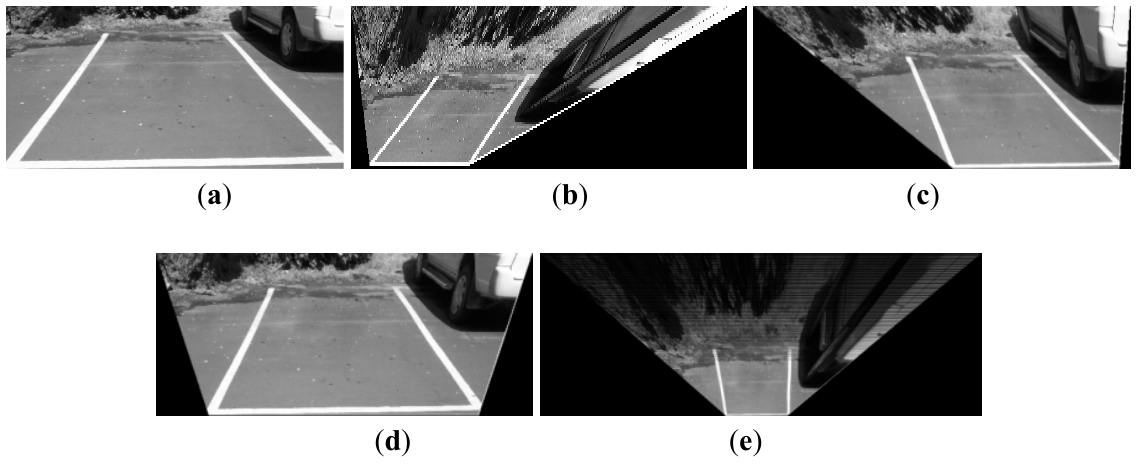
Figure 6. Example of TVTM transformed images with different parameter values of H, f and θ ; ( a ) Source image; ( b ) Skewed to left side; ( c ) Skewed to right side; ( d ) Too wide in the bottom side ; ( e ) Too short in the bottom